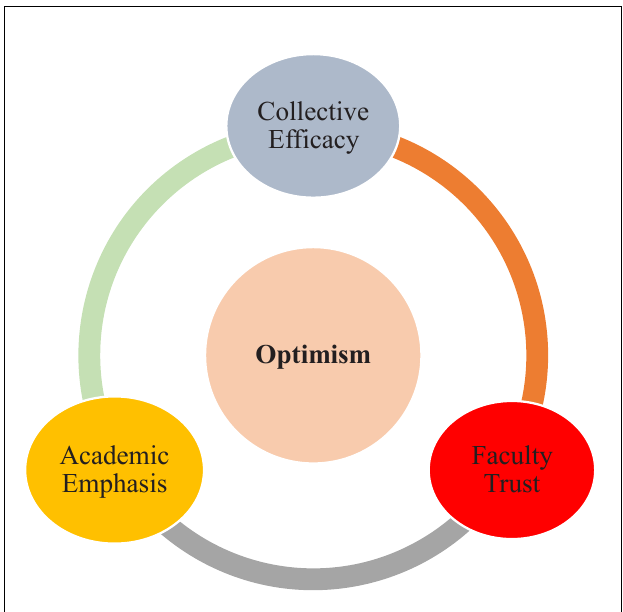
FIGURE 2 | The dimensions of optimism (Hoy et al.,